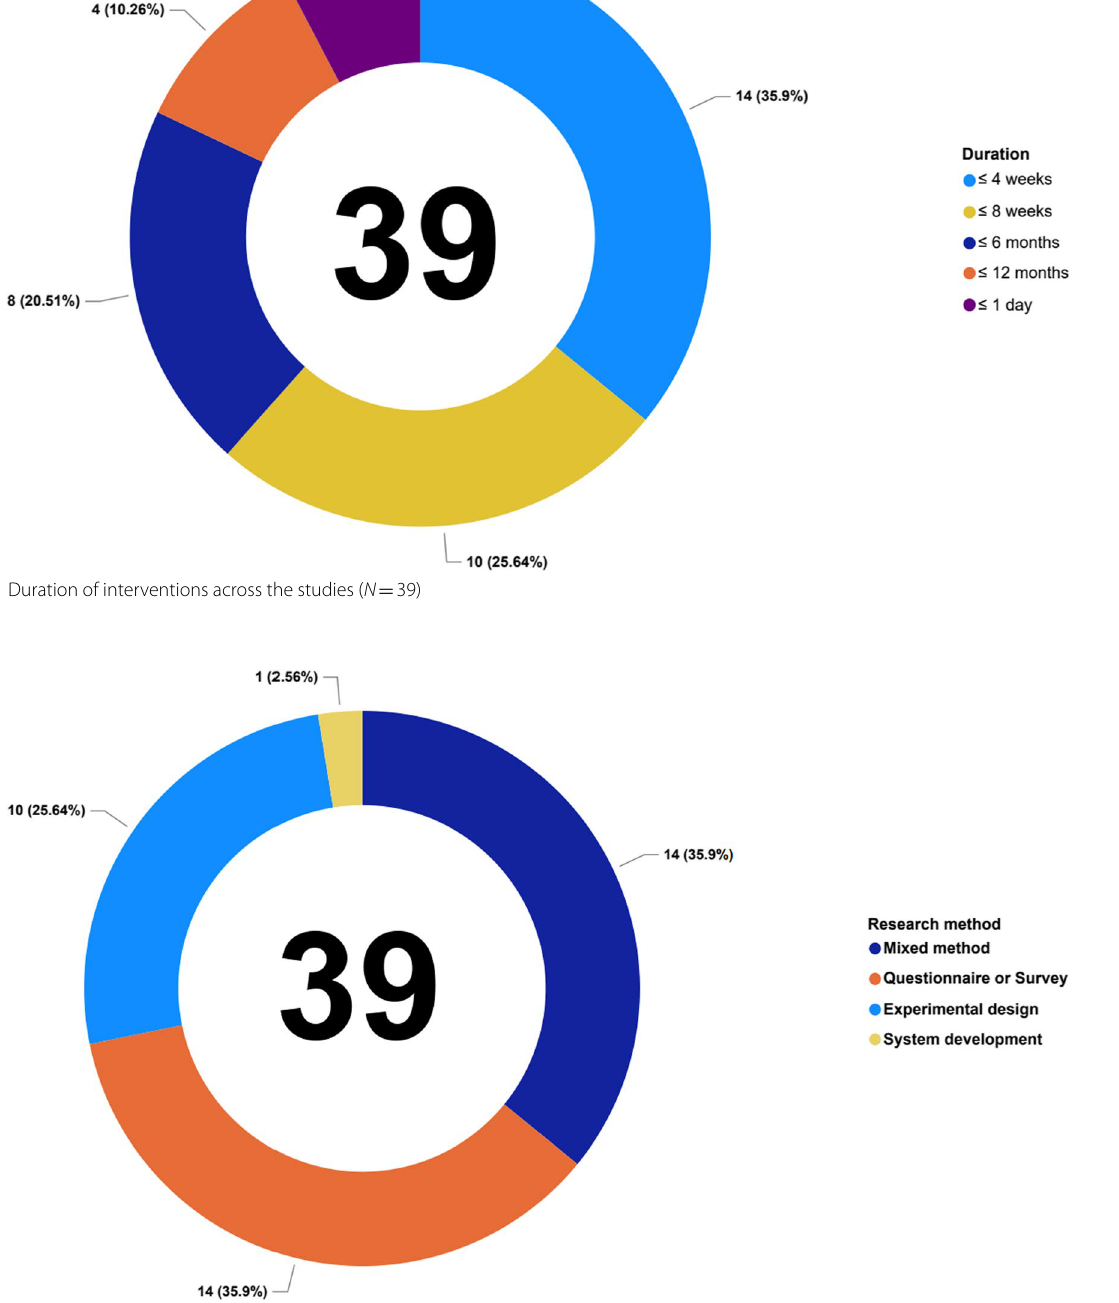
Fig. 7 Frequency of each research method used in